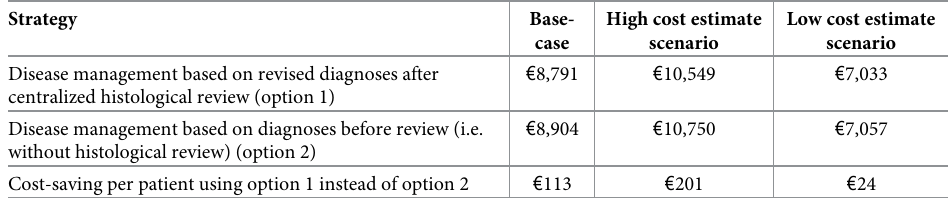
Table 9. Expected costs per patient for base-case, high cost, and low cost estimate scenarios (in € for 2013).